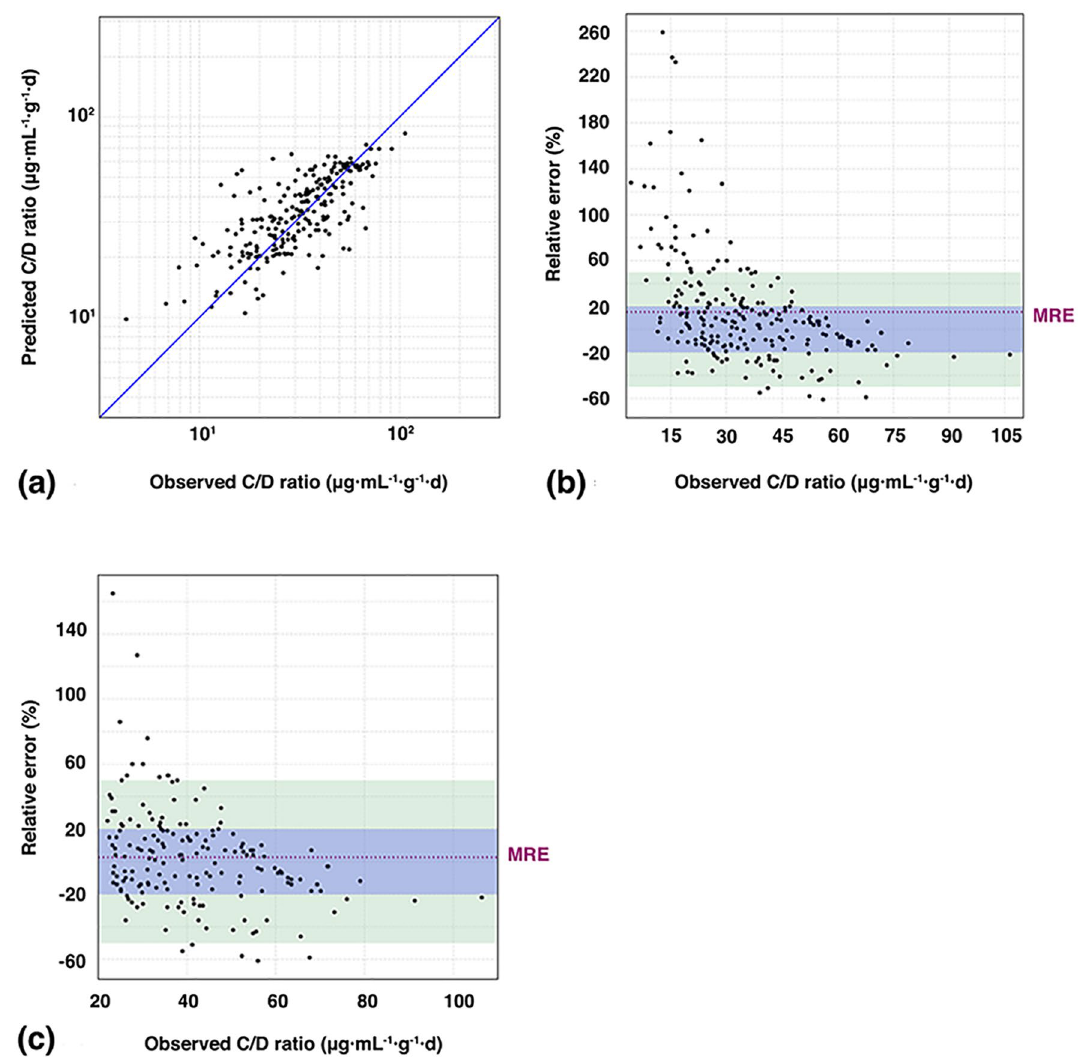
Figure 3. Scatter plots of the predicted vs. observed dose-adjusted concentrations (C/D ratio) and relative error (%) vs. observed C/D ratio. ( a ) Goodness-of-fit plot for model prediction of the C/D ratio. ( b ) Relative error (%) vs. observed C/D ratio over the entire range of the C/D ratio. ( c ) Relative error (%) vs. observed C/D ratio over the range ≥ 22.1 μg mL −1 g −1 day. The blue and green areas indicate ± 20% and ± 50% ranges, respectively. MRE mean relative